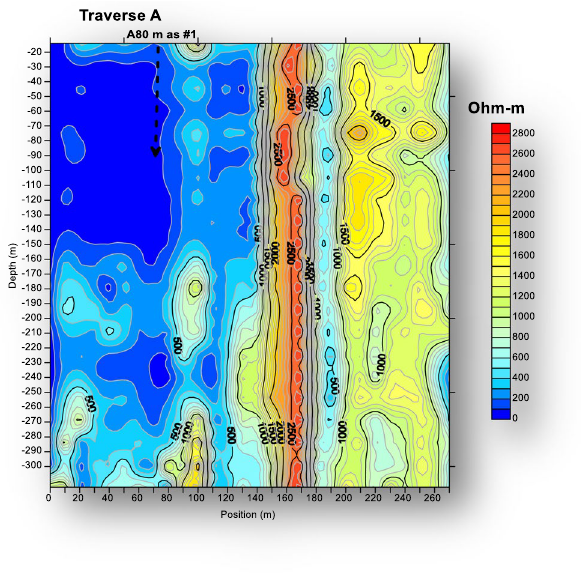
Fig. 3 Two-dimensional-apparent geo-electrical resistivity pseudo- section of the surface at Tawiakwaa underlain by the Tamnean Plu- tonic